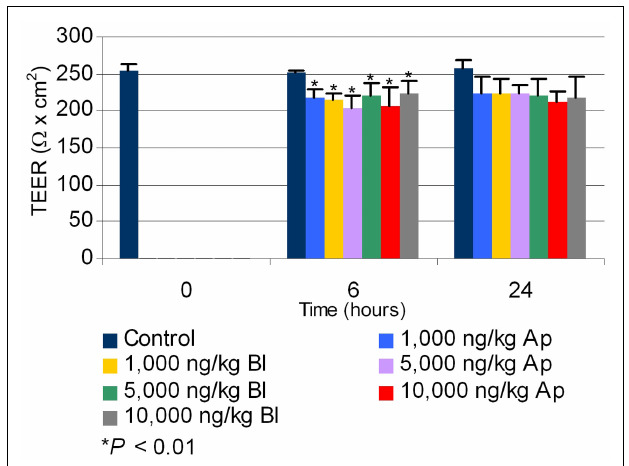
FIGURE 1 | Effects ofAFM 1 treatment on Caco-2/TC7 trans-epithelial electrical resistance (TEER) values. Cells were exposed to different concentrations of AFM 1 (1,000, 5,000, and 10,000ng/kg) in both Ap and Bl sides. A slight (15–20%) but significant ( P < 0.01)TEER decrease was observed starting from the sixth hour of treatment.TEER values were basically unchanged after treatment for 24h. Data are the mean of two separate experiments performed in triplicate ±